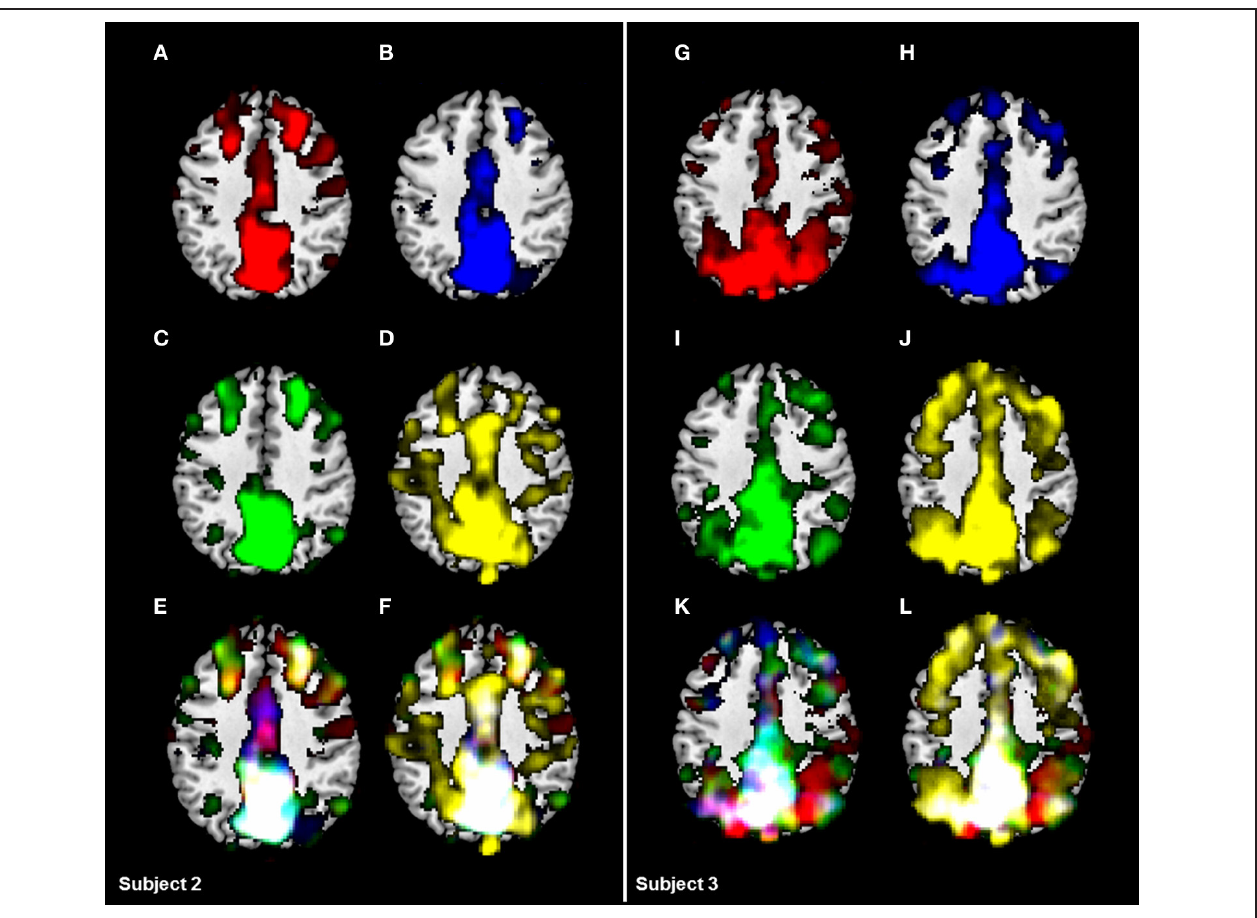
one subject (spatial overlaps of any two conditions ranging from 0.58 to 0.66 in subject 3), but considerable differences of activation maps between two subjects for the same condition (spatial overlaps ranging from 0.39 to 0.57). However, a significant increase of overlap was found excluding the eyes-closed condition (E/K) .